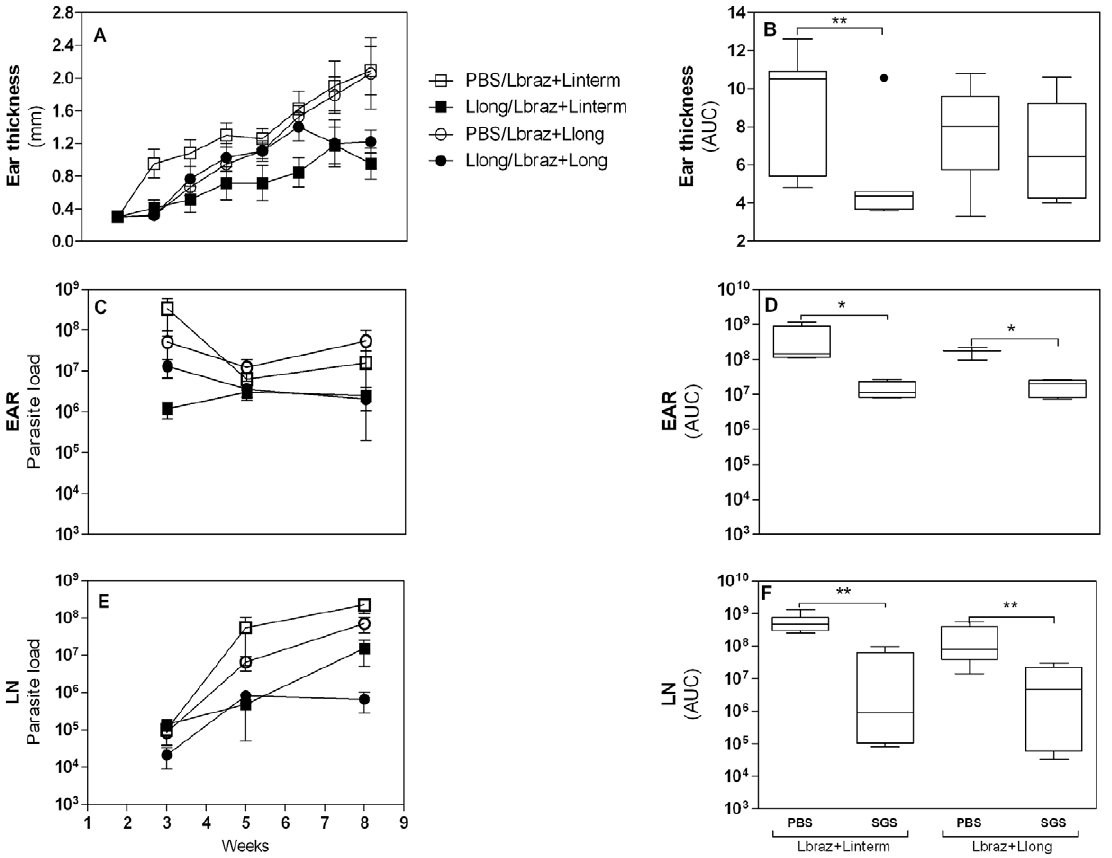
Figure 2. Ear thickness and parasite load in Lu.longipalpis SGS immunized hamsters following infection with L.braziliensis . Hamsters were inoculated three times in the right ear dermis with Lu. longipalpis SGS (closed symbols) or with saline (open symbols) and were infected in the left ear with 10 5 L. braziliensis stationary promastigotes in the presence of Lu. intermedia SGS (squares; 7 hamsters per group total) or Lu. longipalpis SGS (circles, 8 hamsters per group total). The course of lesion development was monitored weekly (A). The points represent the means and the vertical bars represent standard errors of the means. The areas contained under the curves (AUC) obtained in A for each group was compared (B). The parasite number in the ear (C, D) or draining lymph node (E, F) was evaluated by Limiting Dilution Assay (LDA), estimated by ELIDA in 3, 5 and 8 weeks after the infection. Each bar represents the mean and the vertical bars represent standard errors of the means. The disease burden of the ear (C) or draining lymph node (E) show reduced parasite load in immunized hamsters evaluated by Mann-Whitney non-parametric t test. The areas contained under the curves (AUC) obtained in C and E for each group was compared (D, F) and the experiments were repeated five times. *p , 0.05; **p , 0.01.